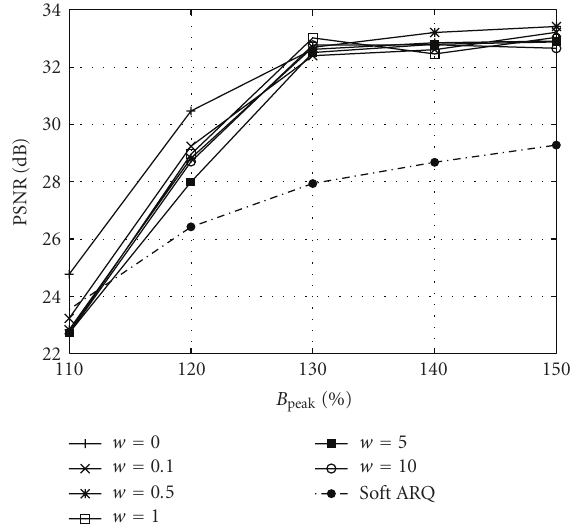
Figure 7: PSNR as a function of the peak bandwidth for the pro- posed ARQ scheme for di ff erent values of the w parameter, com- pared to the MAC-level ARQ performance ( bus sequence). The maximum PSNR values achieved by the MAC-level ARQ and the CBRL ARQ techniques are not reported because they are very low.